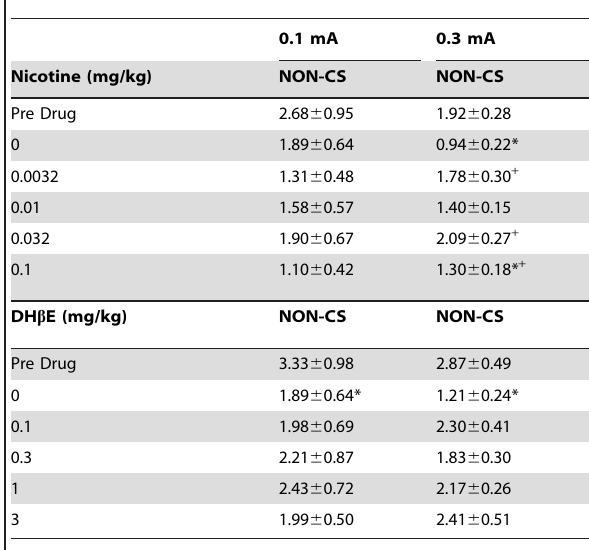
Table 1. Lever pressing activity during the CS and Pre-CS period.